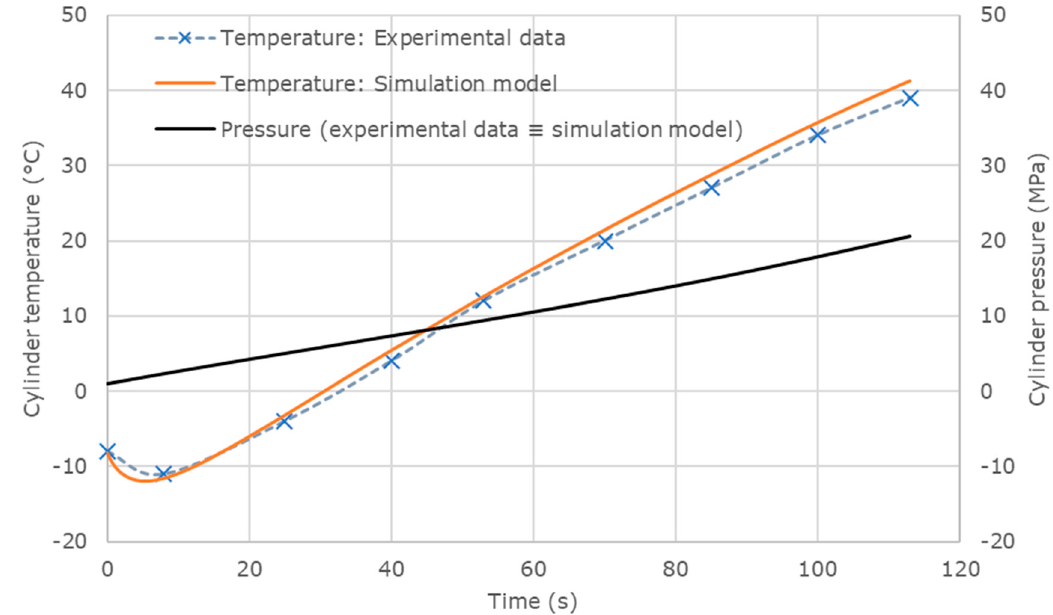
Figure 5. Comparison between experimental [20] and numerical results.